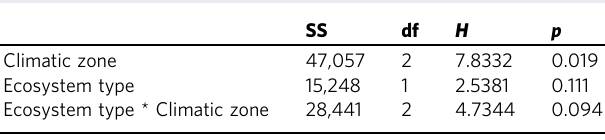
Table 1 Scheirer – Ray – Hare test of the effects of ecosystem type, climate zone, and their interactions on soil respiration amino sugar content (characterization of microbial